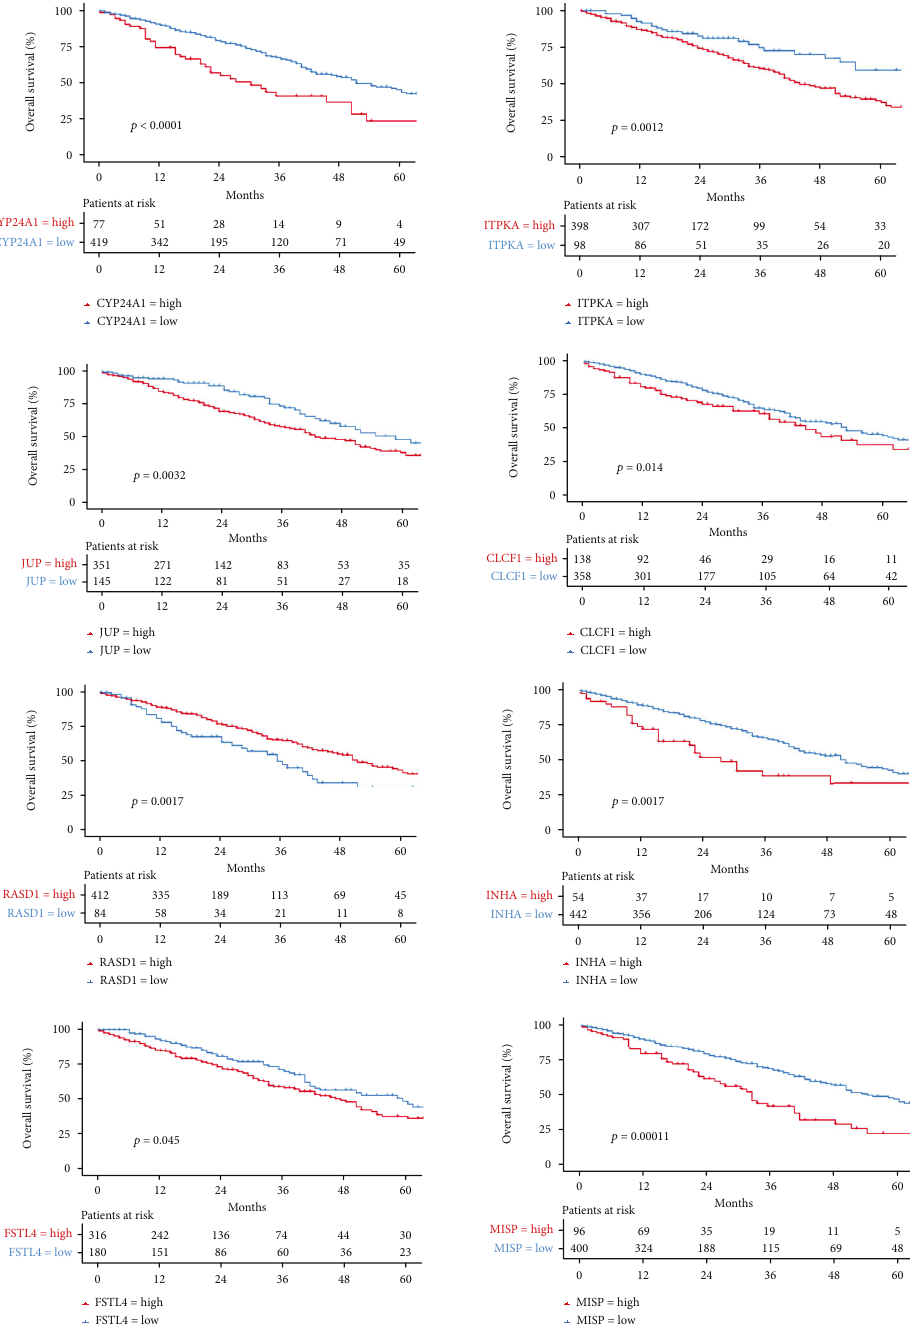
Figure 7: Kaplan-Meier curves of OS about eight genes in LUAD patients from